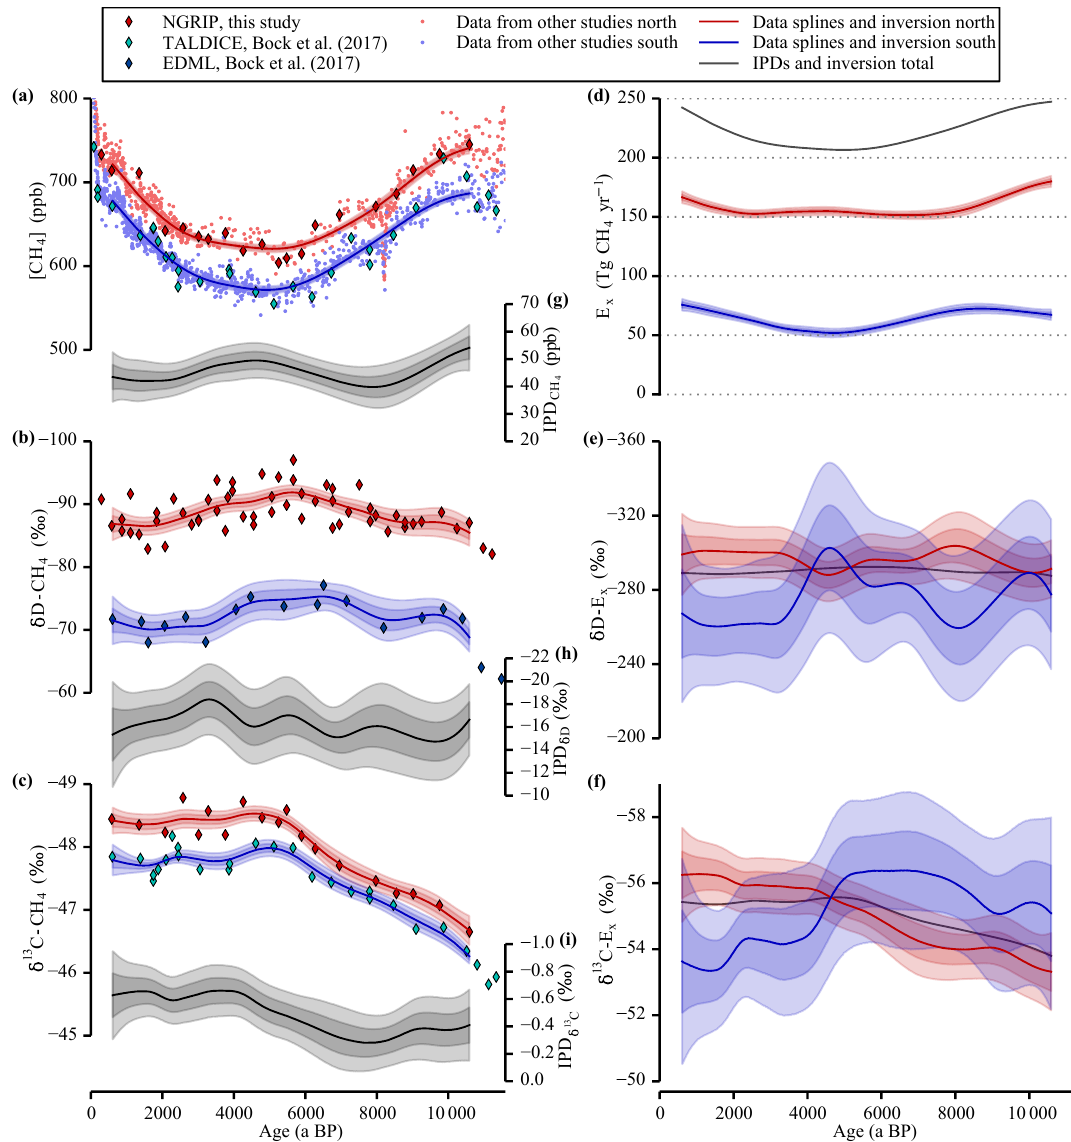
Figure 3. Data and inversion. The panels on the left (a–c) show the concentration and the two stable isotope signatures of CH 4 measured in ice cores representing the tropospheric values over the Holocene. The concentration data are complemented with data from other studies (see Table 1). All three parameters were measured on ice cores from Greenland (red) and from Antarctica (blue and cyan) representing the northern and the southern polar troposphere, respectively. A spline function with a cut-off period of 3000 years has been used to calculate the smoothed evolution of the tropospheric signals represented by the lines and the 1 σ and 2 σ error bands. The panels (g) , (h) , and (i) show the IPDs of all three parameters also with their 1 σ and 2 σ error bands. A box model inversion is used to calculate the hemispheric CH 4 emissions shown in the panels on the right. In panel (d) the emission strengths are shown for both hemisphere boxes together with the total CH 4 emissions. Panels (e) and (f) show the mean isotopic signatures of the emissions for both stable isotopes of CH 4 . All the error bands represent 1 σ and 2 σ uncertainties. Note the inverted y axes in panels (b) , (c) , (e) , (f) , (h) , and (i) . Red refers to Northern Hemisphere records and blue to Southern Hemisphere records throughout the